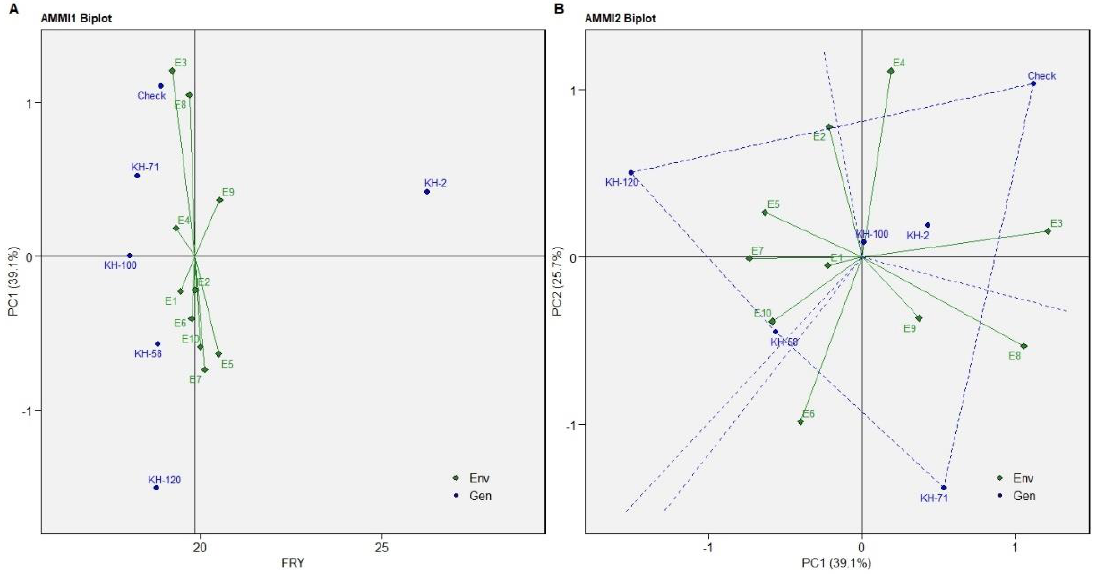
Figure 4. ( A ) AMMI1 biplot ( B ) AMMI2 biplot of FRY of five selected accessions and the check variety of C. caesia germplasm for ten environments.